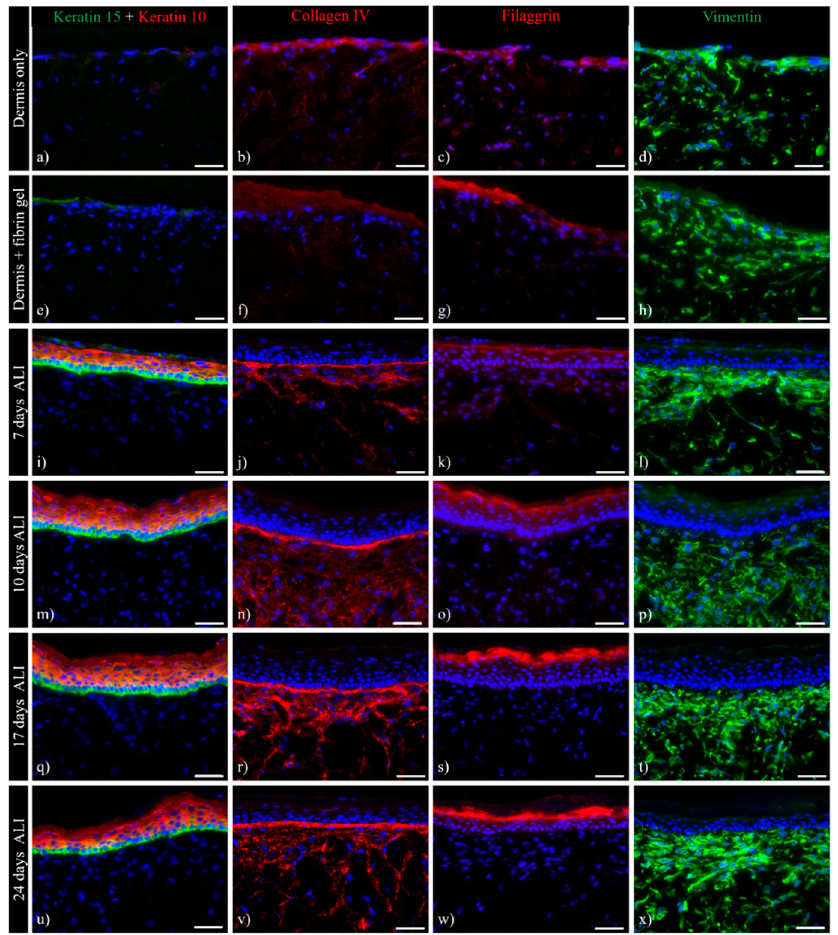
Figure 8. Immunohistochemistry of ftSEs. Expression of skin-specific markers was observed over time. Representative images of ( a , d ) dermis only and ( e , f ) dermis with added fibrin gel, as well as ftSEs after ( i – l ) seven days air lift (ALI), ( m – p ) 10 days ALI, ( q – t ) 17 days ALI, and ( u – x ) 24 days ALI were selected for further analysis. Column 1 ( a , e , i , m , q , u ) shows keratin 10 (red)/15 (green) double immunostaining. Column 2 ( b , f , j , n , r , v ) shows collagen IV, Column 3 ( c , g , k , o , s , w ) shows filaggrin, and Column 4 ( d , h , l , p , t , x ) shows vimentin staining. An increase in epidermal differentiation and basement membrane marker expressions at different time points indicates a physiologically relevant skin development. Counterstaining of cell nuclei with DAPI (blue). Scale bar: 50 μ m.